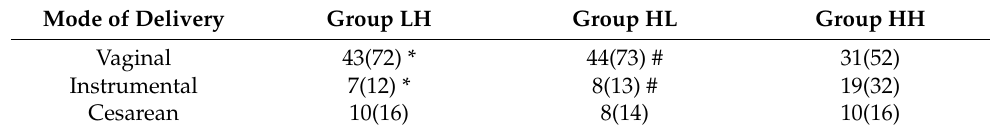
Table 4. Comparison of mode of delivery among the three groups [ n